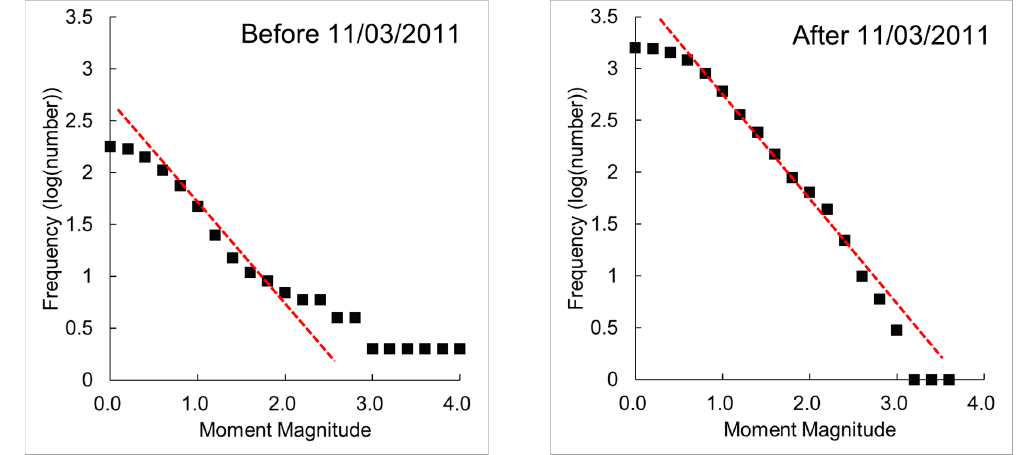
Figure 5. Histograms showing the Gutenberg-Richter relation.